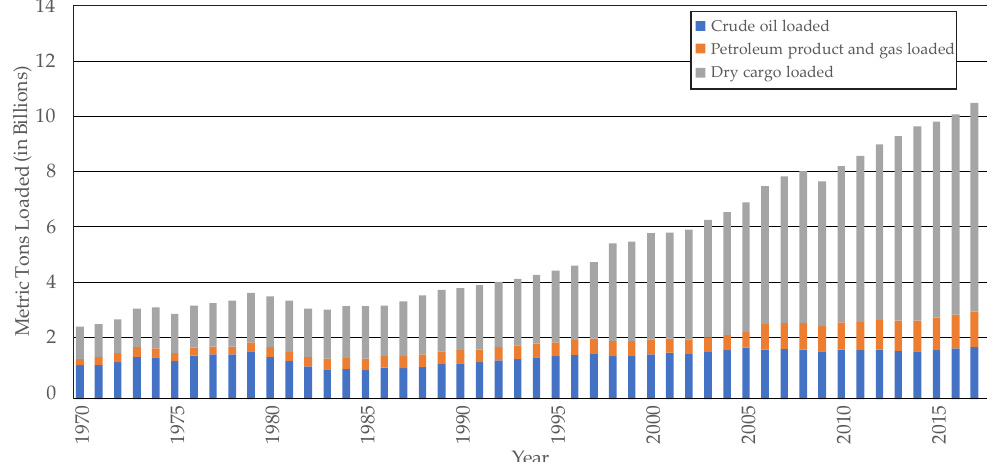
Figure 2. Annual world seaborne trade from 1970 to 2017 according to the United Nations Conference on Trade and Development